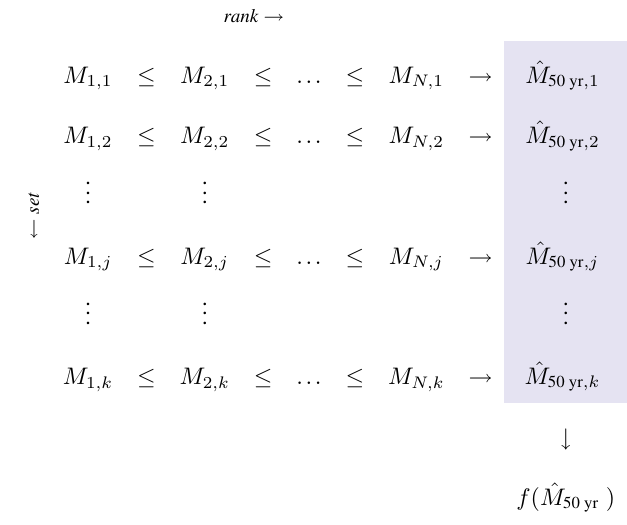
cording to f ( ˆ M 50yr ):